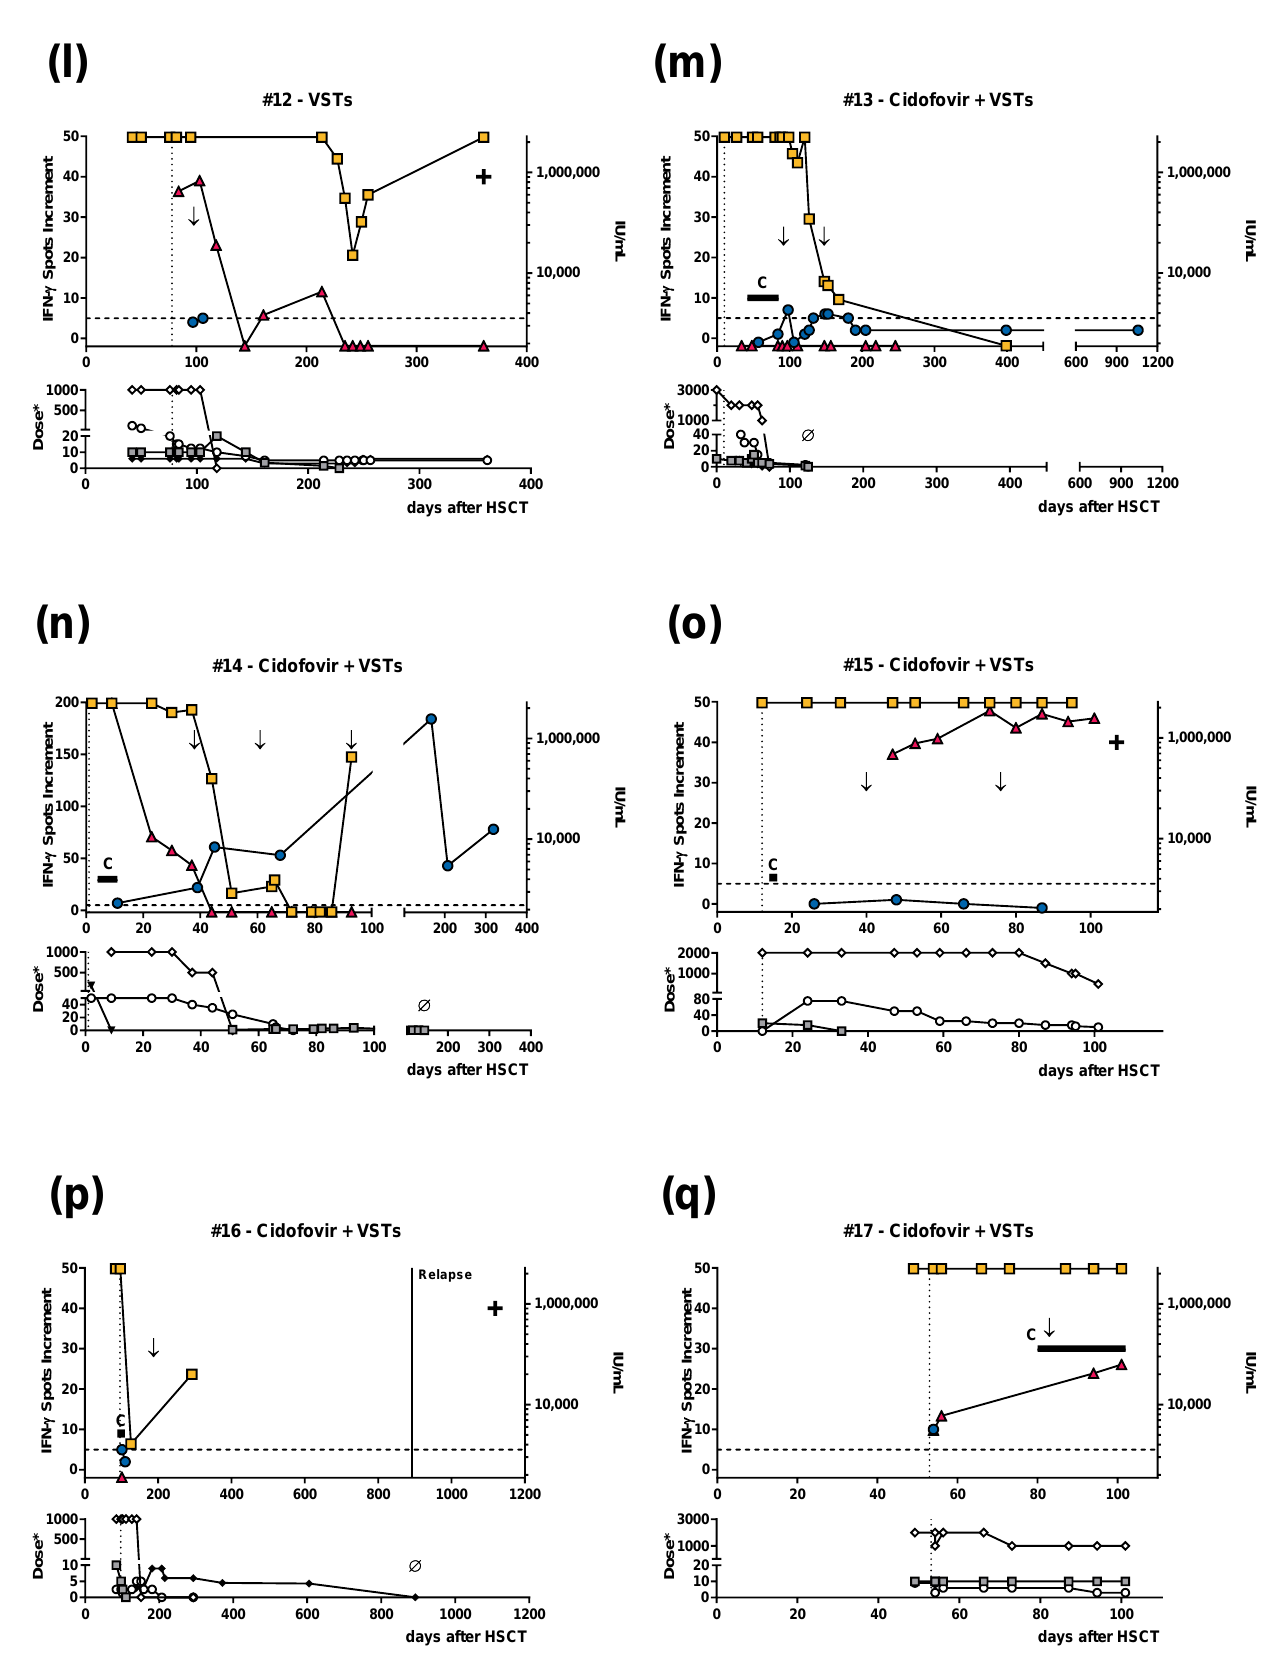
Figure 1. Follow-up data of hematopoietic stem cell transplant (HSCT) recipients who suffered from BK virus (BKV)-related cystitis. The dotted vertical line indicates the onset of